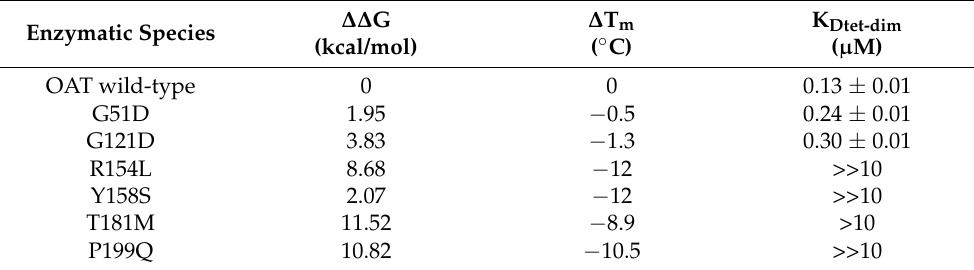
Figure 2. In silico analysis of the position and possible local effects of the mutations. The dimeric structure of hOAT is represented in cartoon style and the PLP-Lys292 complex is represented as orange sticks. Monomers are differently colored as grey/purple and green/cyan for the wild-type and mutated hOAT structures, respectively. Panel ( A ), representation of the structural position of the residues subjected to mutation on the hOAT wild-type structure, the mutation sites are indicated and highlighted as yellow sticks. Panels ( B – G ), over imposition of the OAT wild-type structure and the mutated structures of ( B ) G51D, ( C ) G121D, ( D ) R154L, ( E ) P199Q, ( F ) Y158S and ( G ) T181M, obtained by in silico mutagenesis. * Residues belonging to the neighboring subunit. Image was obtained by PyMol software (Schrödinger, New York, NY, USA). Table 1. ∆∆ G, ∆ T m and K Dtet-dim of wild-type hOAT and variants. Predicted values of ∆∆ G of dimerization calculated by the BindProfX. ∆ T m : difference between the T m value of the hOAT wild-type (67.8 ◦ C) and that of the variants; K Dtet-dim : tetramer ↔ dimer equilibrium of dissociation constant of hOAT wild-type and the